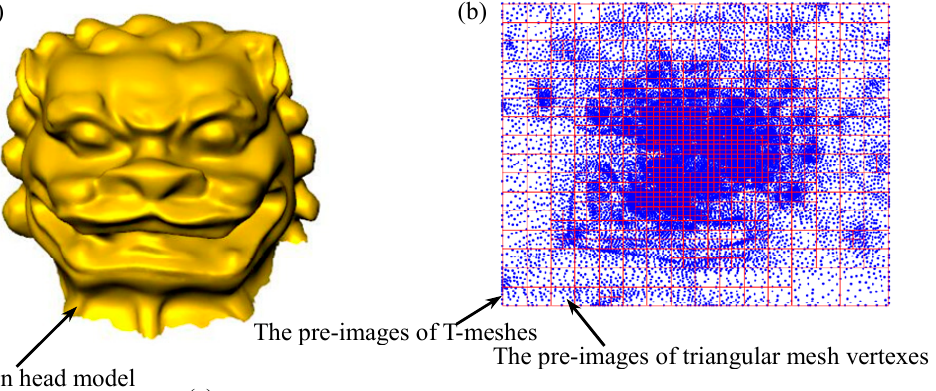
Figure 7. Knee bone model as an example of fitting T-splines, ( a ) the original knee bone model, ( b ) the pre-image of T-meshes and triangle mesh vertexes, ( c ) the spatial distribution of control points and T-meshes.